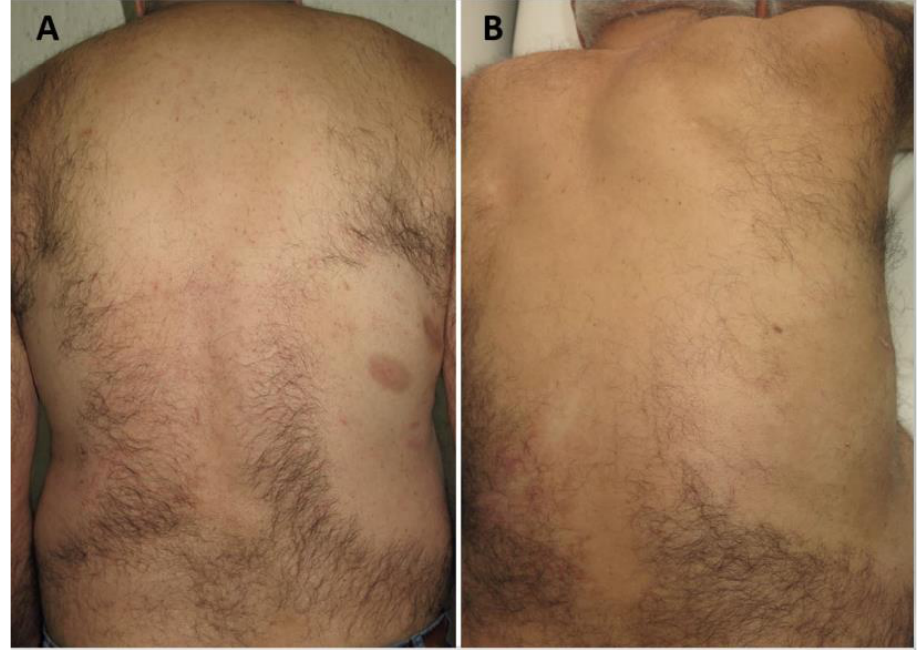
Figure 1. A complete response in a patient with paucilesional MF treated with 2 sessions of MAL-c- PDT. ( A ) is before the treatment, while ( B ) is after the treatment. Table 1. Recent literature on the use of PDT on primary cutaneous T-cell lymphomas.